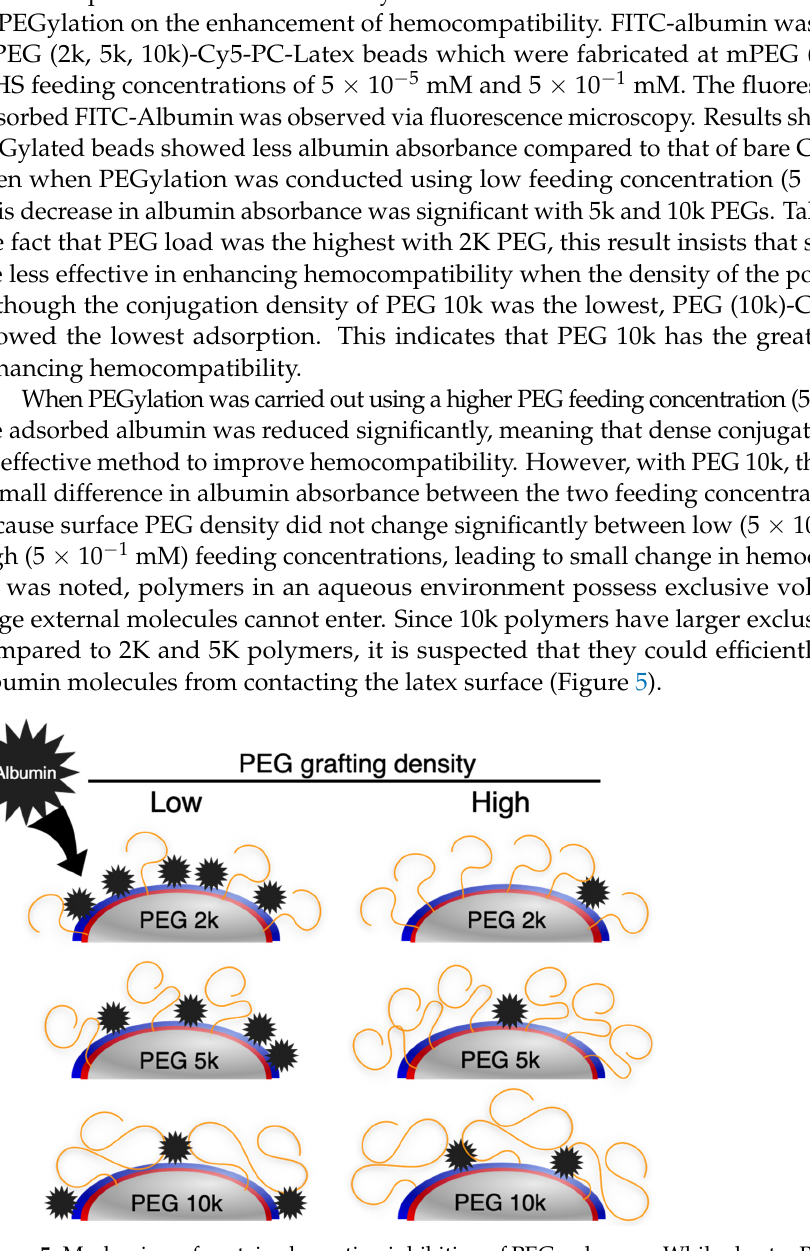
Figure 5. Mechanism of protein absorption inhibition of PEG polymers. While shorter PEGs (e.g., PEG 2k) must distribute densely among the latex surface to inhibit albumin from reaching the latex surface, longer PEGs (e.g., PEG 10k), due to their large exclusive volume, can cover a larger surface area to efficiently inhibit albumin